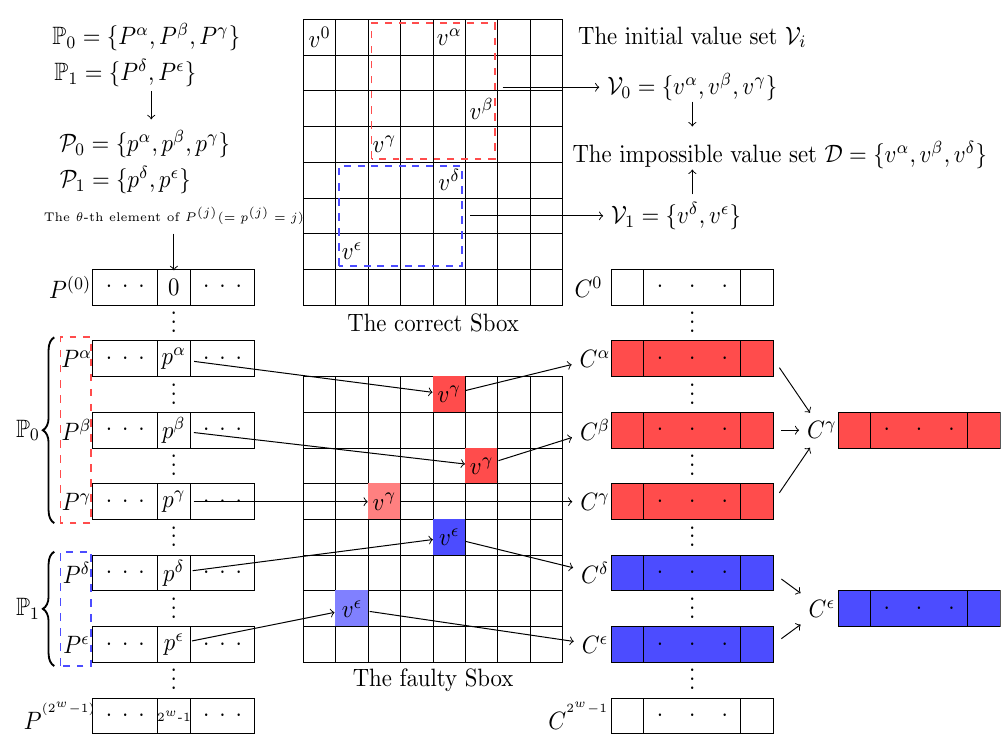
Figure 1: The overview of Fault Model and Core